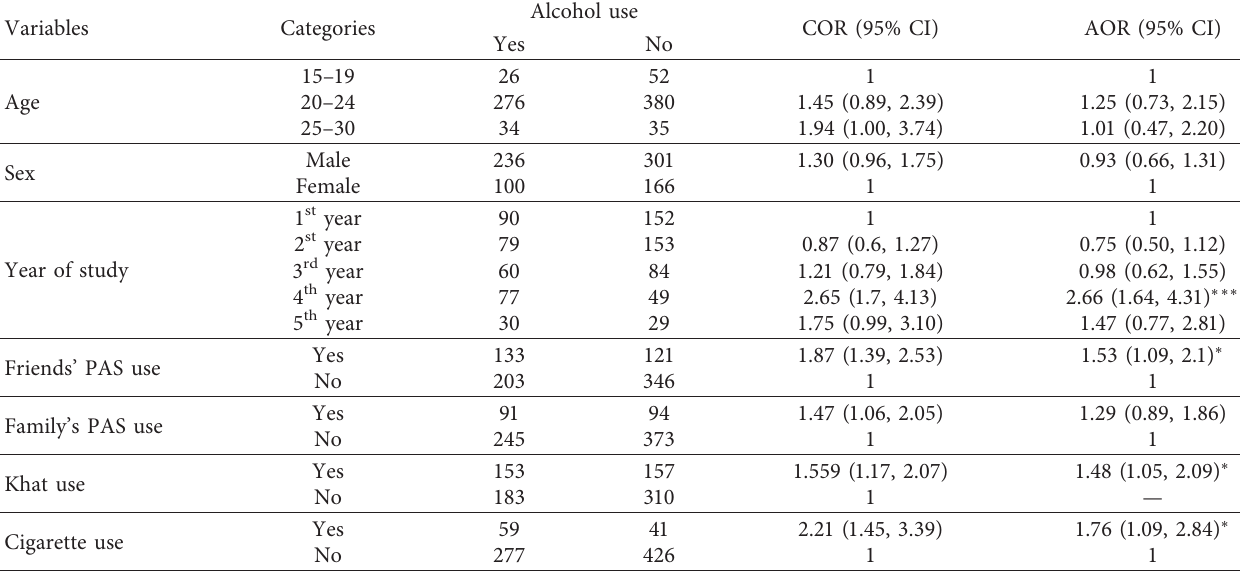
Table 3: Bivariate and multivariate logistic regression analysis showing alcohol drinking among Dilla University students in Ethiopia, 2018.